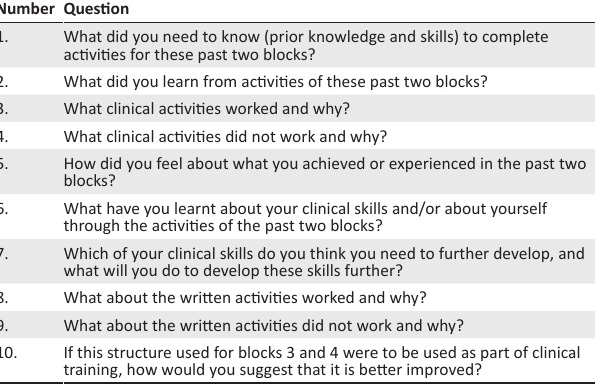
TABLE 1: Open-ended questions on which students’ reflections were based